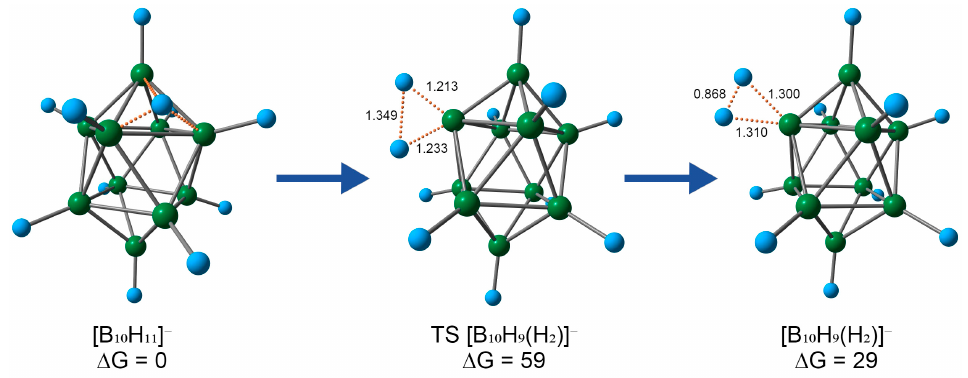
Figure 3. Isomerization process of [B 10 H 11 ] − to [B 10 H 9 (H 2 )] − . Length units—Å, energy units—kJ/mol, ω B97X-D3/def2-TZVPP level of theory.